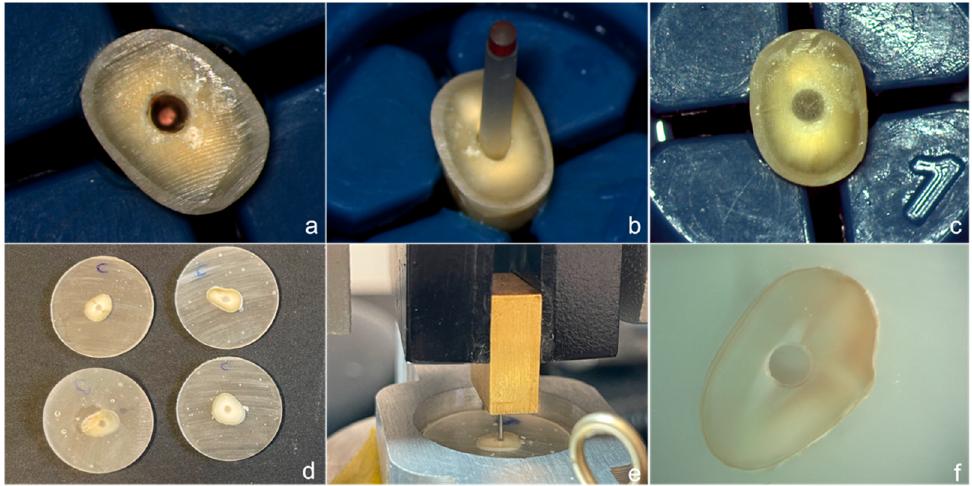
Figure 1. Images showing procedure: ( a ) root canal after obturation; ( b ) Glass fiber post try-in; ( c ) fiber post cementation; ( d ) One mm slice sections in acrylic blocks; ( e ) Mounted section prior to push-out testing; ( f ) and after testing.